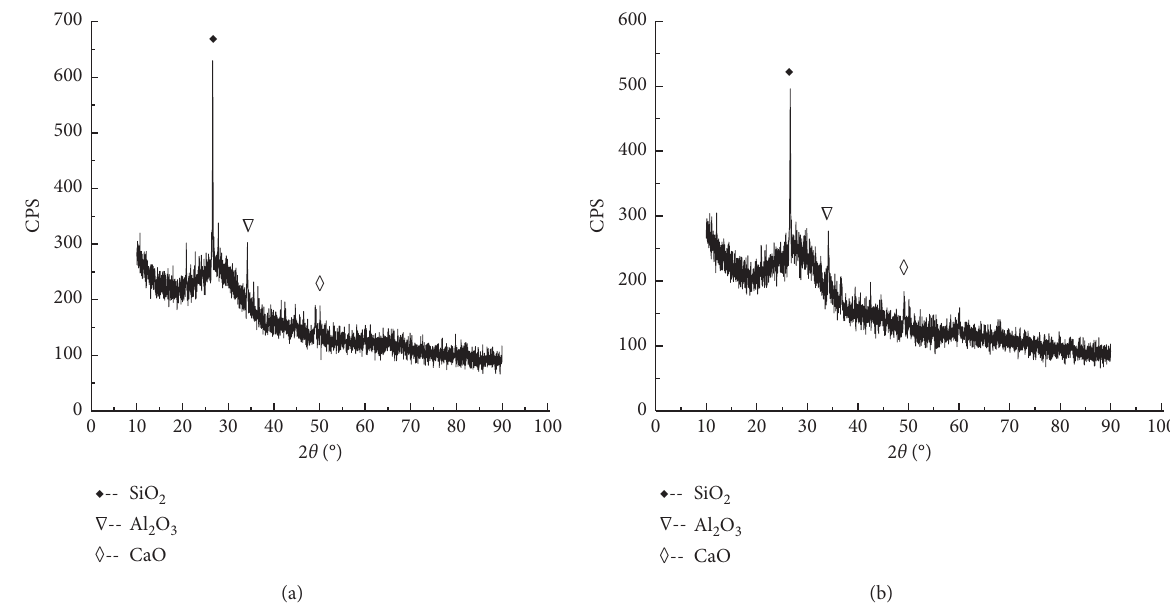
Figure 1: XRD patterns of the EMR after different grinding times. (a) 25min. (b) 50min. Table 2: Basic properties of the matrix asphalt. Test